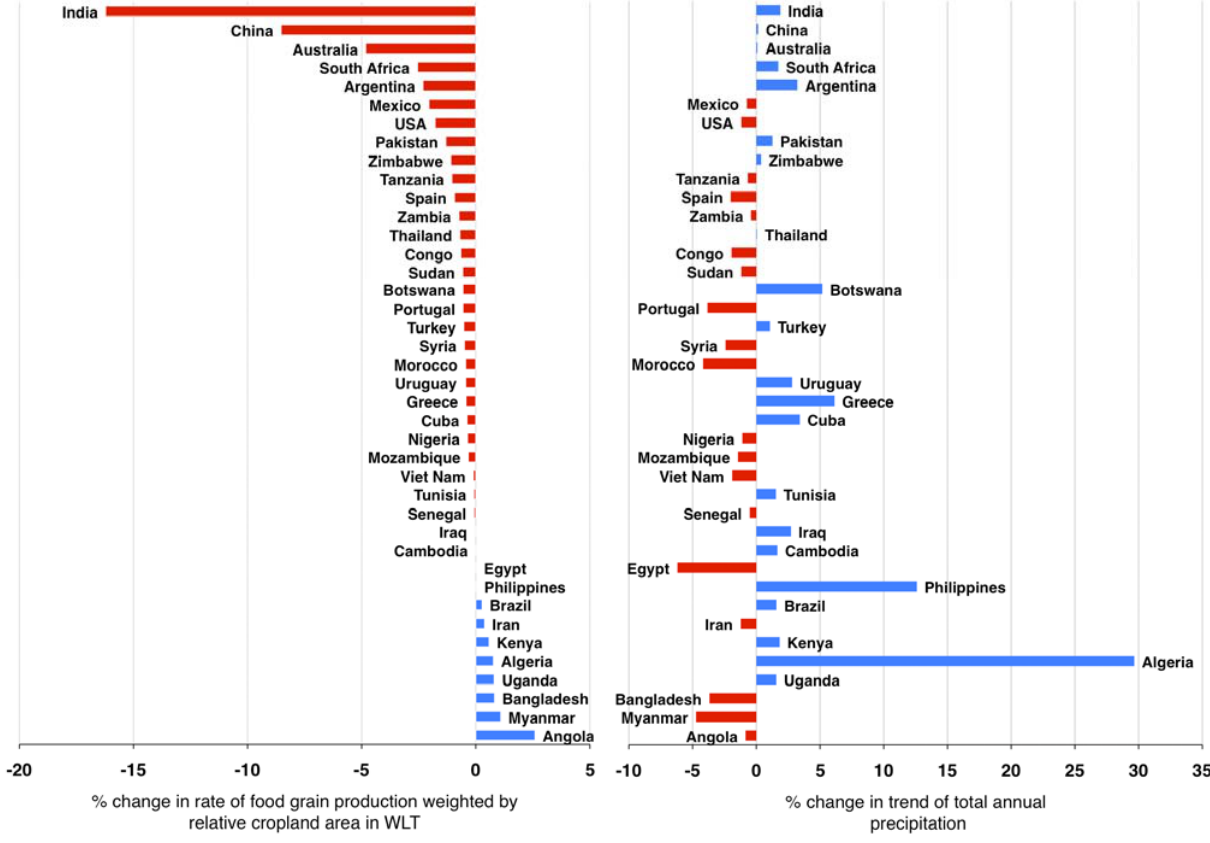
Figure 2. Change (%) in rate of food grain production (left) and in trend of total annual precipitation (right) during 1996–2006 relative to 1966–1996 in major WLT countries. For each country, the change (%) in rate of food grain production is weighted by the relative cropland area in WLT (identified in Figure